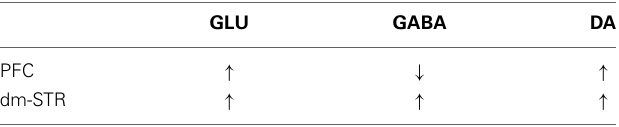
Data from: Ceglia et al., 2004; Calcagno et al., 2006, 2009; Carli et al., 2011a,b; Agnoli et al., 2013. ↑ , increase; ↓ ,